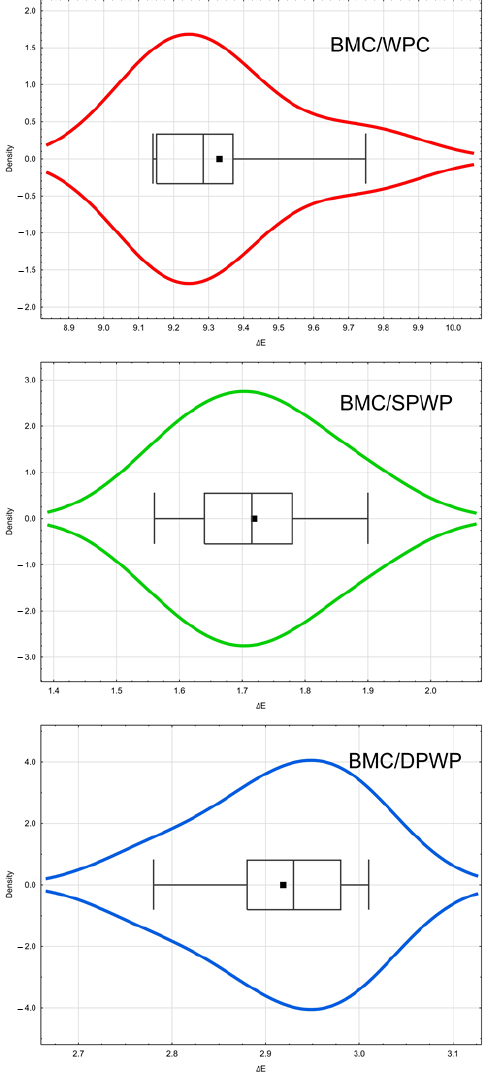
Figure 3. Total color difference of buttermilk cheeses with and without addition of whey protein. BMC/WPC, BMC/SPWP, BMP/DPWP: the same at Table 1; ΔE, total color difference.